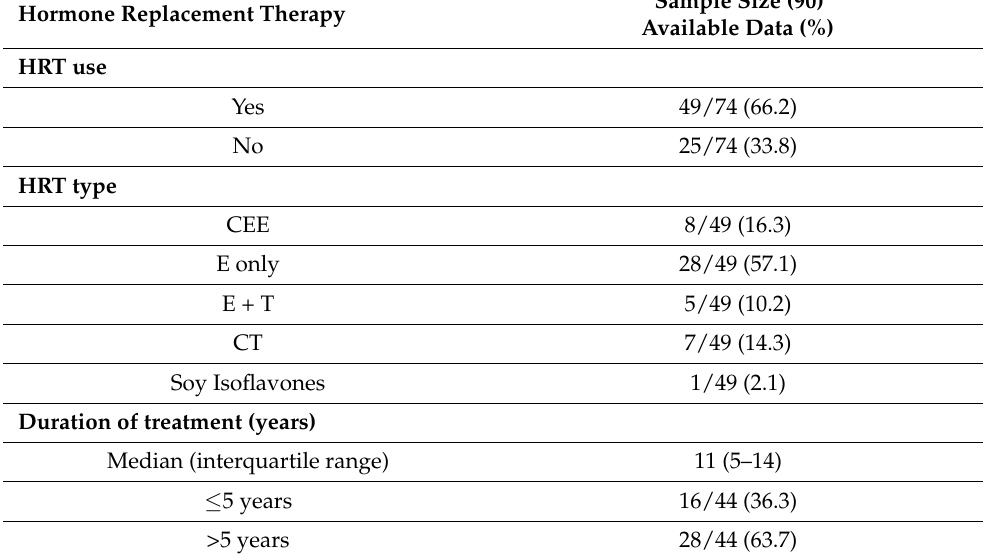
Table 3. Hormone replacement therapy